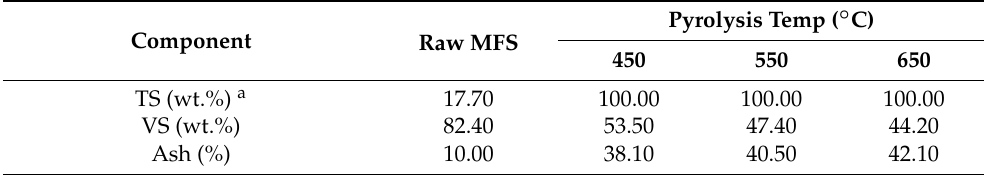
Table 1. Physicochemical characterisation of raw MFS and MFS biochars produced at varying temperatures.